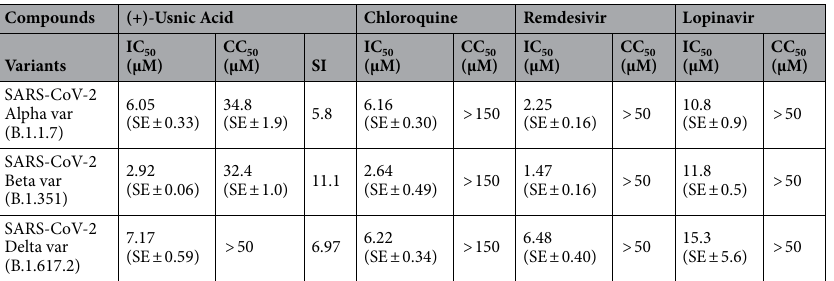
Table 5. The antiviral efficacy of (+)-usnic acid and controls against the SARS-CoV-2 variants [Alpha (B.1.1.7), Beta (B.1.351), and Delta